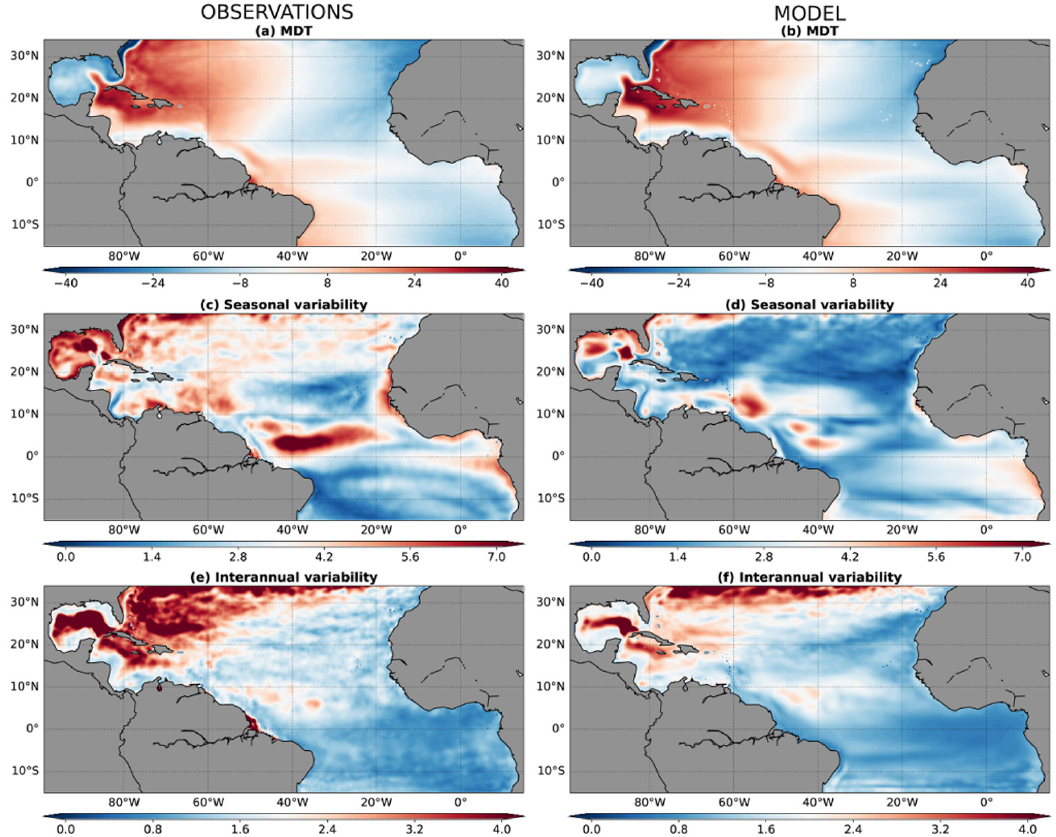
Figure 4. Comparison between observation and model sea levels: ( a , b ) Mean Dynamic Topography (regional mean are removed) from ( a ) CLS and ( b ) model; ( c , d ) standard deviation of seasonal sea level (monthly time series) from ( c ) CMEMS data and ( d ) model; ( e , f ) standard deviation of detrended interannual sea level (annual time series) from ( e ) CMEMS data and ( f ) model. Units are in centimeters. The considered period is